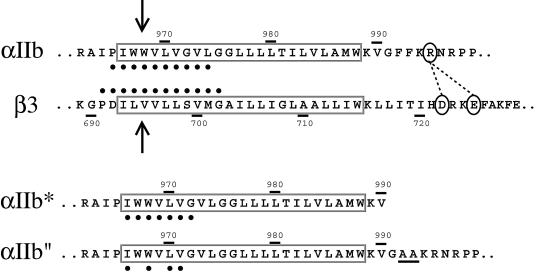
Sequences of the αIIb and β3 TM RegionsSegments predicted as TM by TMHMM version 2.0 (Krogh et al. 2001) are boxed. The more C-terminal KVGFF sequence in αIIb and KLLITI sequence in β3 are additionally predicted to be in the membrane by Armulik et al. (1999). Charged residues involved in intersub-unit salt bridges (dotted lines) in the NMR cytoplasmic domain structure (Vinogradova et al. 2002) are marked with ovals. Residues used for cysteine scanning in this study are indicated by heavy dots. Arrows show the boundary between residues forming disulfide bonds constitutively and after oxidation. The se-quences of the αIIb* GFFKR truncation and αIIb" GFFKR/GAAKR mutants are also shown.